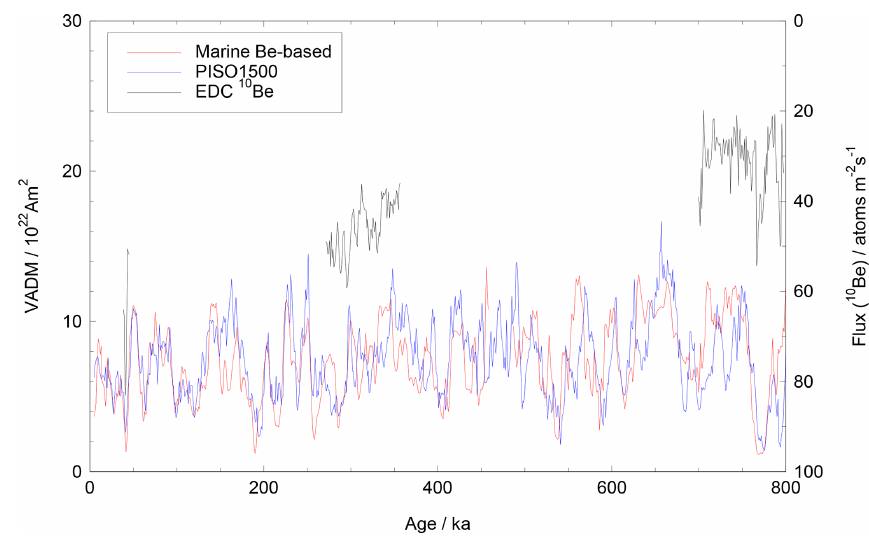
Figure 8. Palaeo-intensity and 10 Be data for the last 800kyr. Virtual axial dipole moment (VADM) from the PISO-1500 palaeo-intensity stack (blue) (Channell et al., 2009); VADM derived from an authigenic 10 Be / 9 Be ratio stack (Simon et al., 2016) using an empirical calibra- tion (red); published 10 Be fluxes from the EDC ice core (black, right axis) (Cauquoin et al., 2015; Raisbeck et al., 2017, 2006).